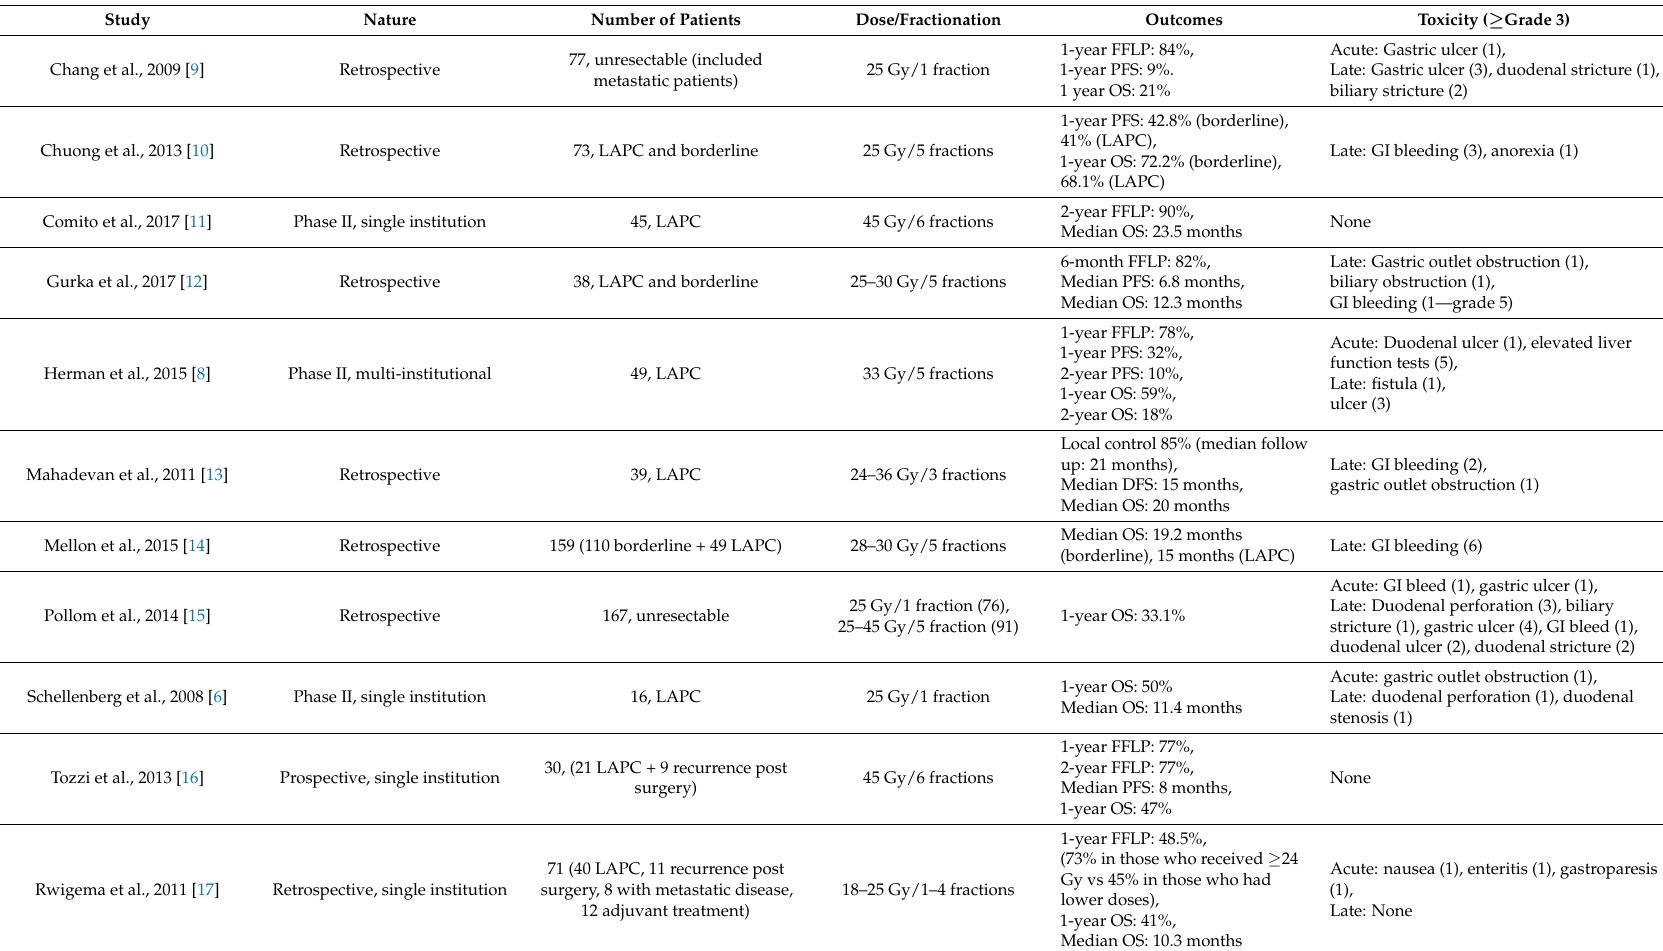
Table 1. Summary of studies reporting on outcomes of patients treated with Stereotactic Body Radiotherapy